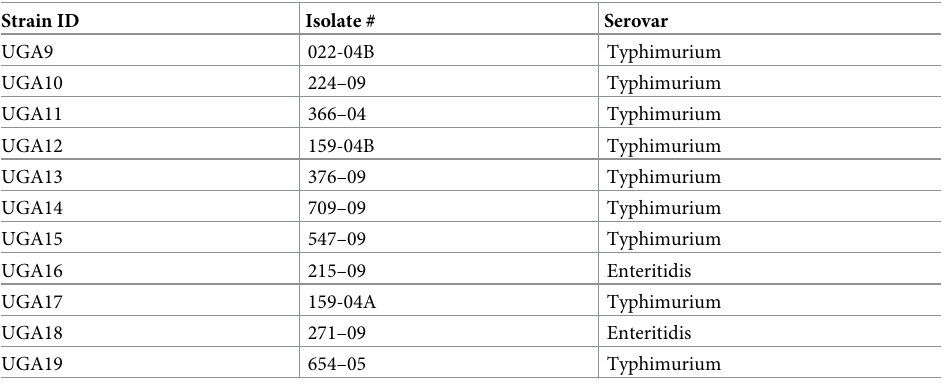
Table 3. Non-typhoidal Salmonella clinical